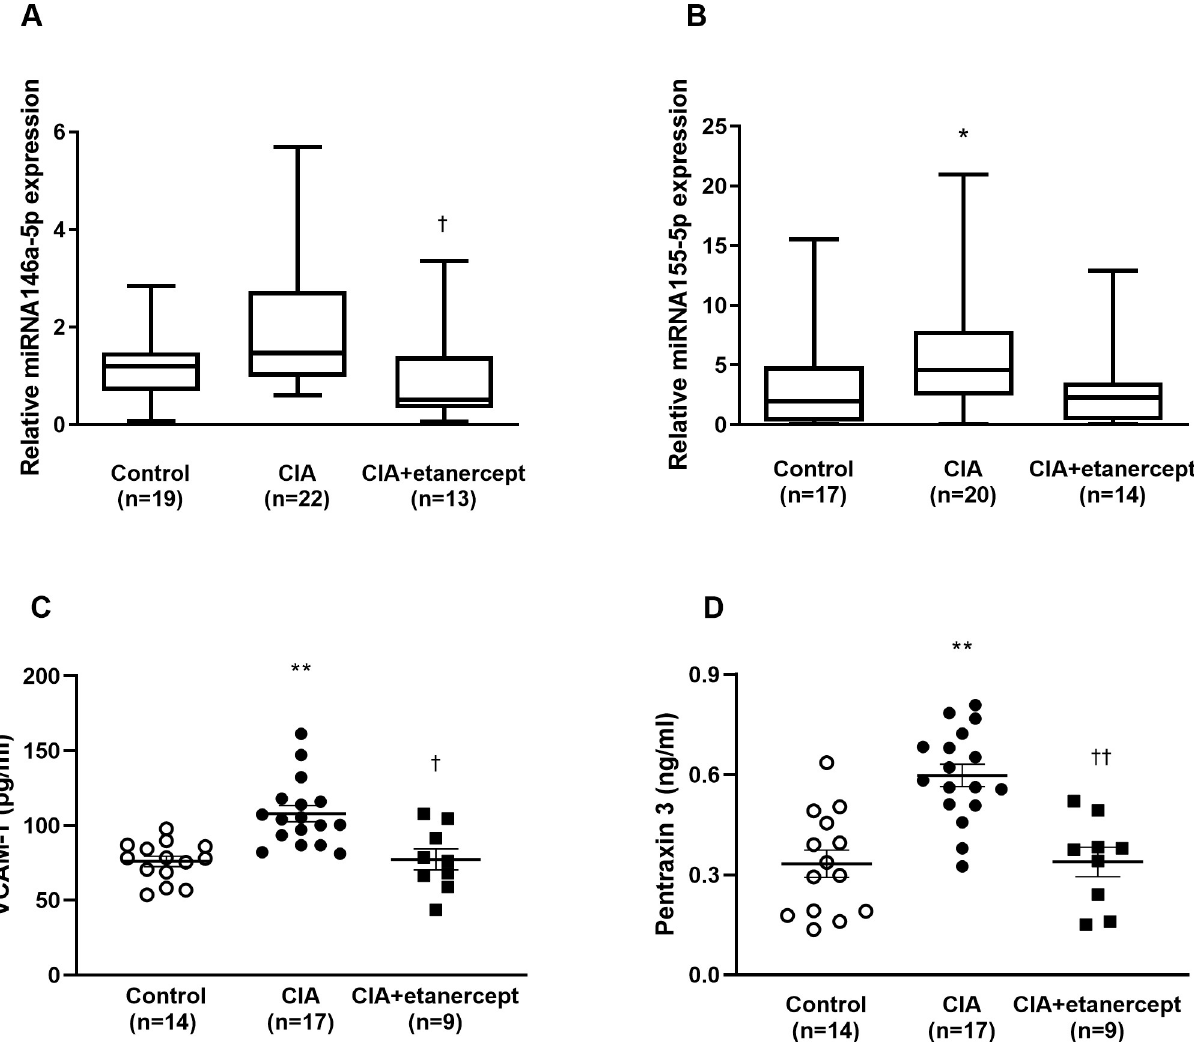
Fig 1. Circulating concentrations of biomarkers of endothelial function in control, CIA and CIA+etanercept groups. Circulating concentrations of miR146a-5p (A), miR 155-5p (B), VCAM-1 (C) and PTX-3 (D) in control, CIA, and CIA+etanercept groups. Data presented as mean ± SEM or median (IQR). � p < 0.05 versus control, �� p < 0.001 versus control. † p < 0.05 versus CIA, †† p < 0.001 versus CIA, using a Kruskal-Wallis test or a two-way ANOVA followed by Tukey post-hoc tests. CIA: collagen-induced arthritis; VCAM-1: Vascular adhesion molecule-1; PTX-3: